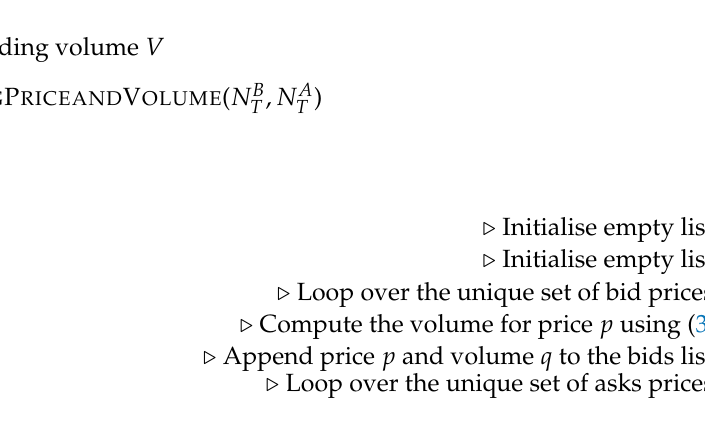
Algorithm 1 Compute Clearing Price and